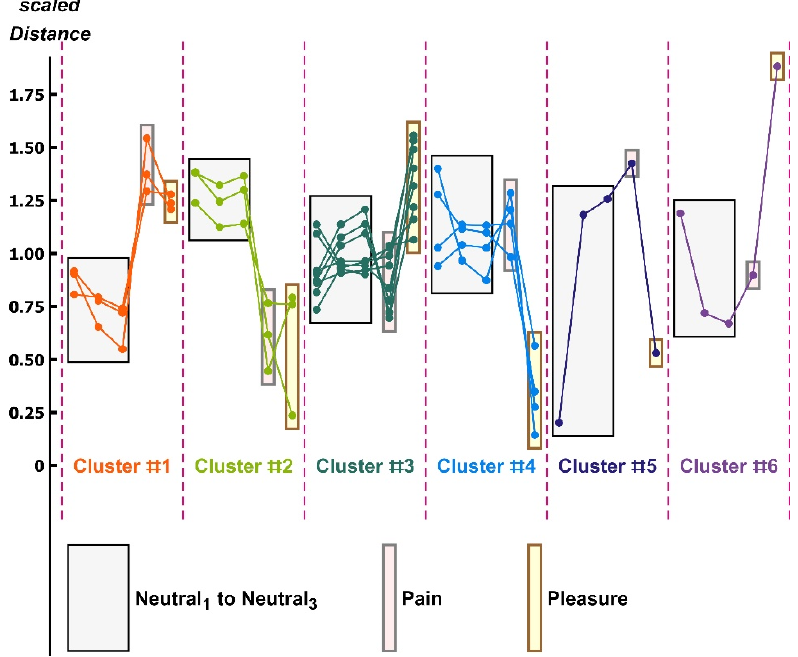
Figure 3. The ML distribution of the pain–pleasure distances for all 20 actresses. The distribution is asymmetric, thus displaying the interval mean ± SD is not meaningful. We used the HD 95% interval [20] to display the uncertainty. The ML mode and ML expectation are close to midway between the ends of the HDI 95% interval, and, furthermore, the ends of this interval are very close to 1 × and 3 × the mode. The shaded area under the pdf-curve has an area of 95%.